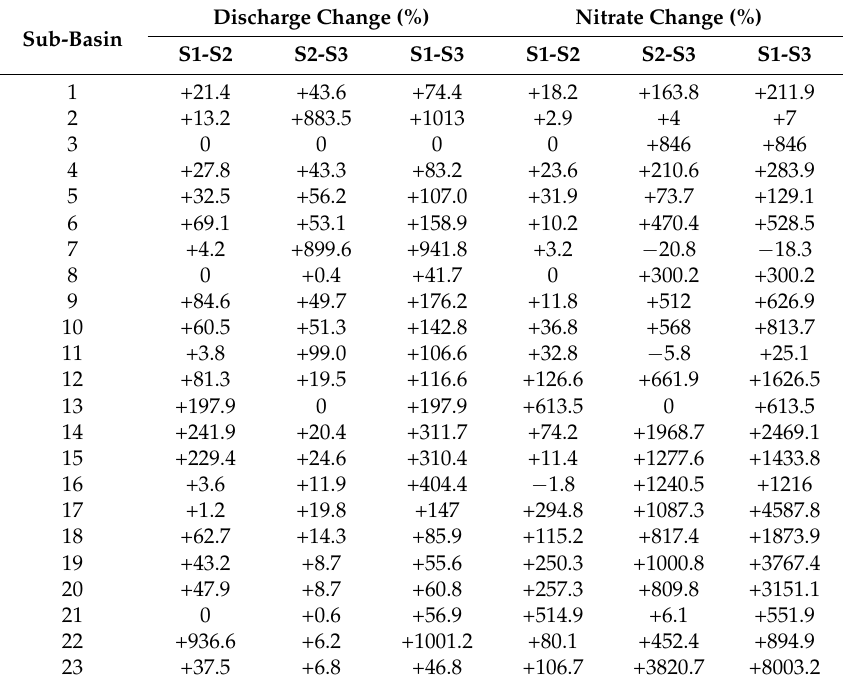
Table 9. Percent changes in simulated average annual discharge and nitrate transport for three land use scenarios (S1: 1991, S2: 2013 and S3: